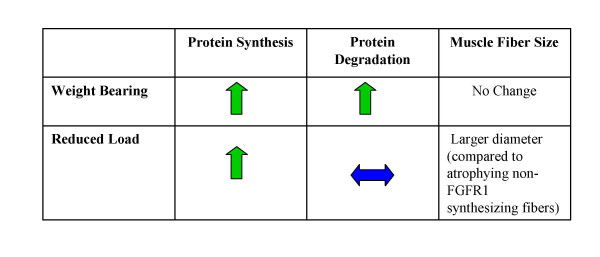
Proposed role of FGFR1 in adult skeletal muscle. Increased production of FGFR1 in a weight bearing muscle fiber would result in an increase in protein synthesis and degradation, which would counteract each other and result in no observable increase in muscle fiber size. However, in a fiber undergoing atrophy, increased FGFR1 would not elevate the significant amount of proteolysis that would already be occurring in an atrophying fiber. However, FGFR1 would still elevate protein synthesis in the atrophic fiber, thereby maintaining fiber size and strength.